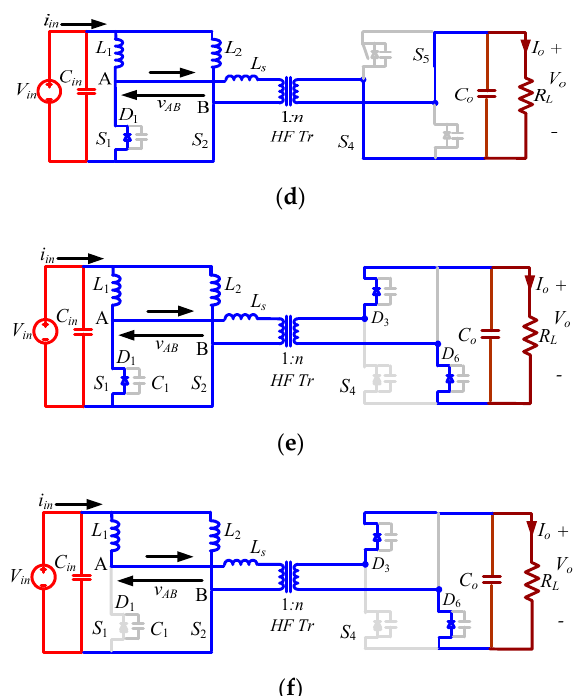
Figure 3. Equivalent circuits during different intervals of the operation for the waveform in Figure 2 Reproduced with permission from [17], IEEE, 2020. ( a ) S 2 in blocking mode; ( b ) S 2 is turned-on; ( c ) ZVS turn-on of S 4 and S 5 ; ( d ) ZCS turn-off of S 1 and body diode conducts; ( e ) D 3 and D 6 start conduction for rectification; ( f ) S 1 goes in blocking mode.